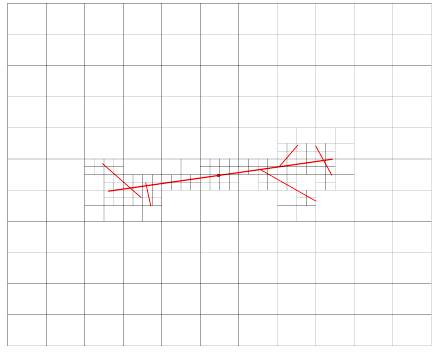
Figure 4. Grid system with the local grid refinement.